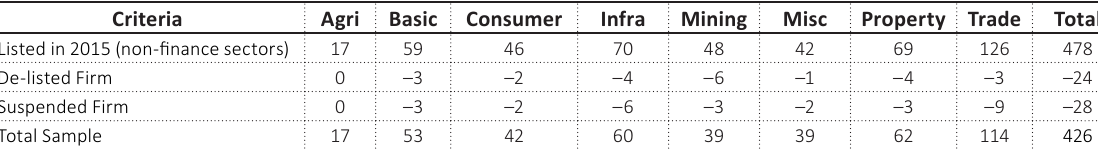
Table 1. Sample selection criteria